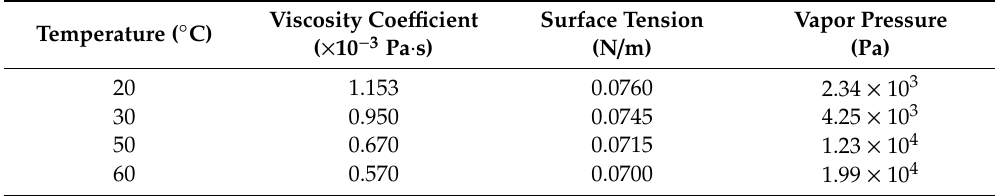
Table 1. Values of the viscosity coefficient, surface tension, and vapor pressure at different temperatures of a 10% NaCl electrolyte solution.